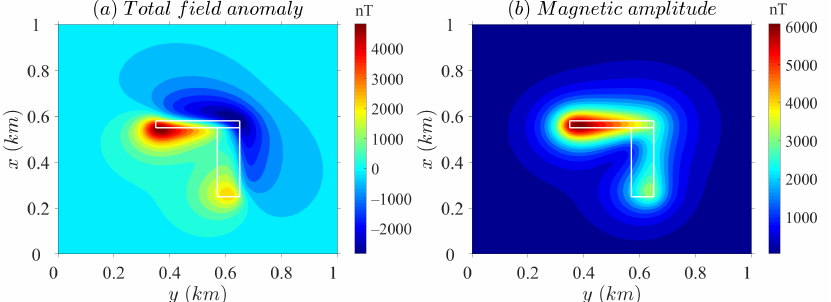
Figure 10. Surface total-field anomaly ( a ) and magnetic amplitude ( b ) due to the two-dike model with a magnetic susceptibility of 3 SI.